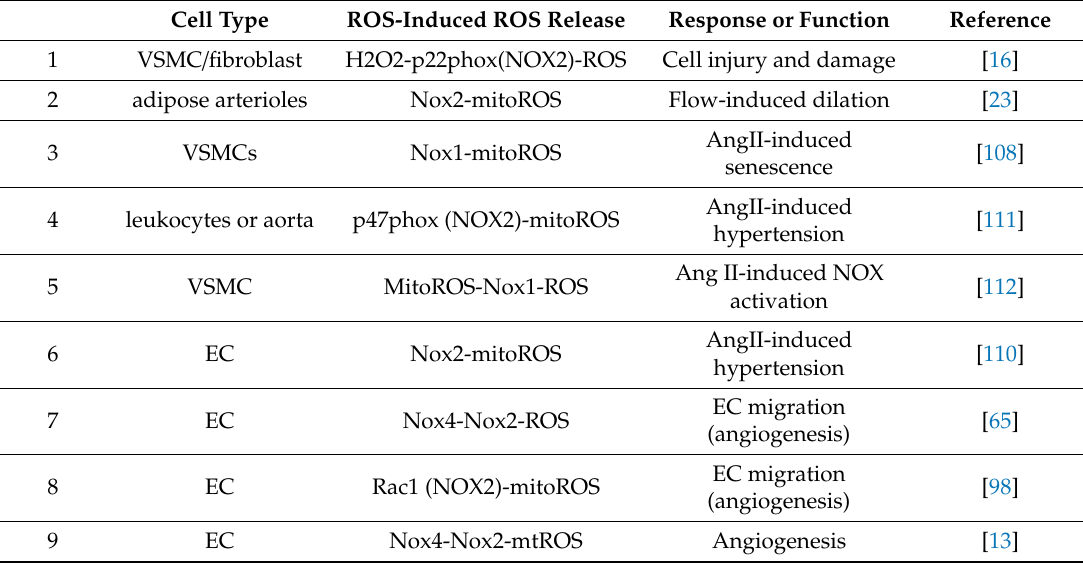
Table 1. Role of ROS-induced ROS release in angiogenesis and vascular